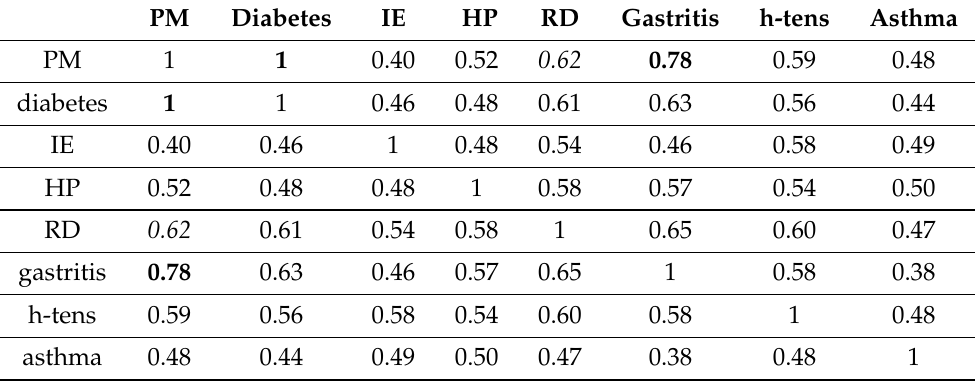
Table 5. ICrA results based on one day of pollution exposure: µ -values. PM Diabetes